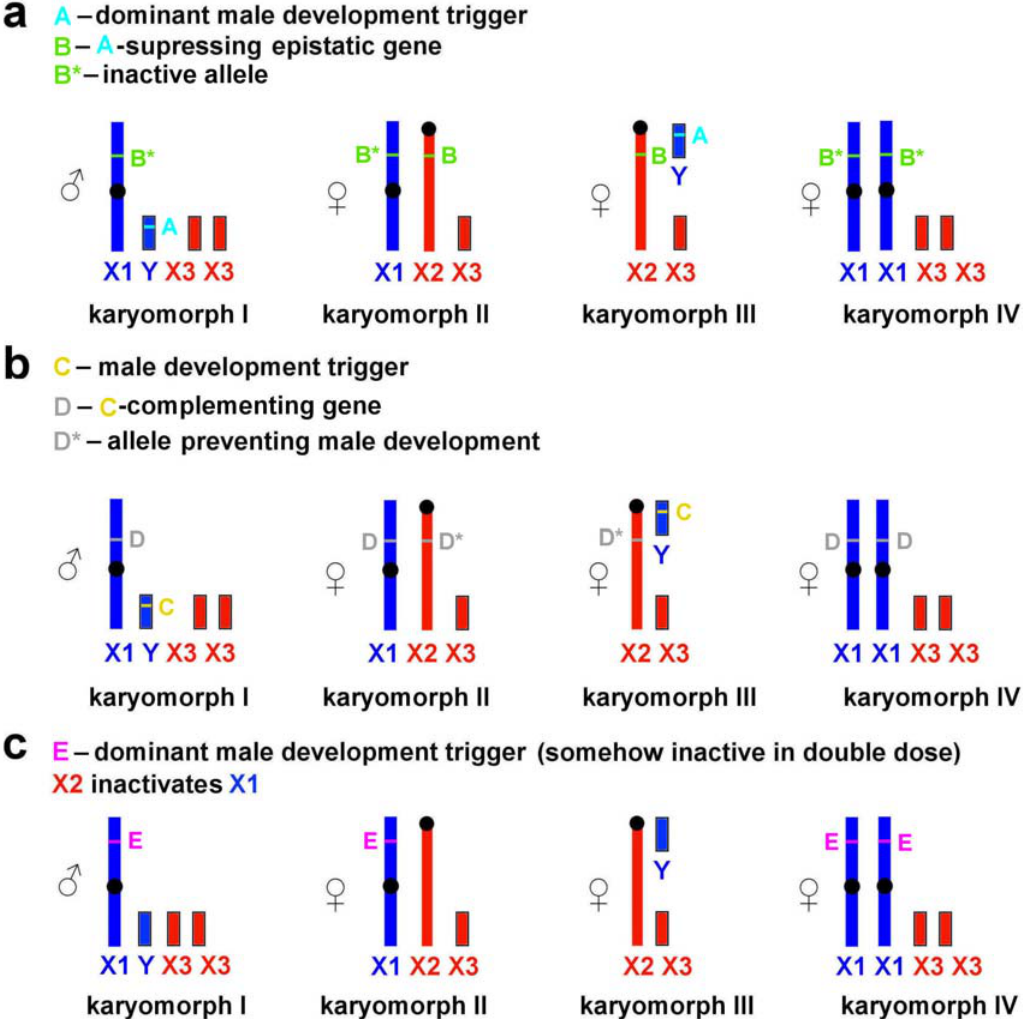
Figure 4. Possible mechanisms of sex determination in Lasiopodomys mandarinus vinogradovi : ( a ) a mechanism suggesting the presence of an epistatic locus on neo-X2 (X2) chromosome suppressing the dominant male development trigger on neo-Y (Y) chromosome, ( b ) a mechanism suggesting the presence of a locus on neo-X1 (X1) chromosome complementing the dominant male development trigger on neo-Y, ( c ) a mechanism suggesting the presence of male development trigger on neo-X1 chromosome and nonrandom inactivation of neo-X chromosomes. See comments in the text.